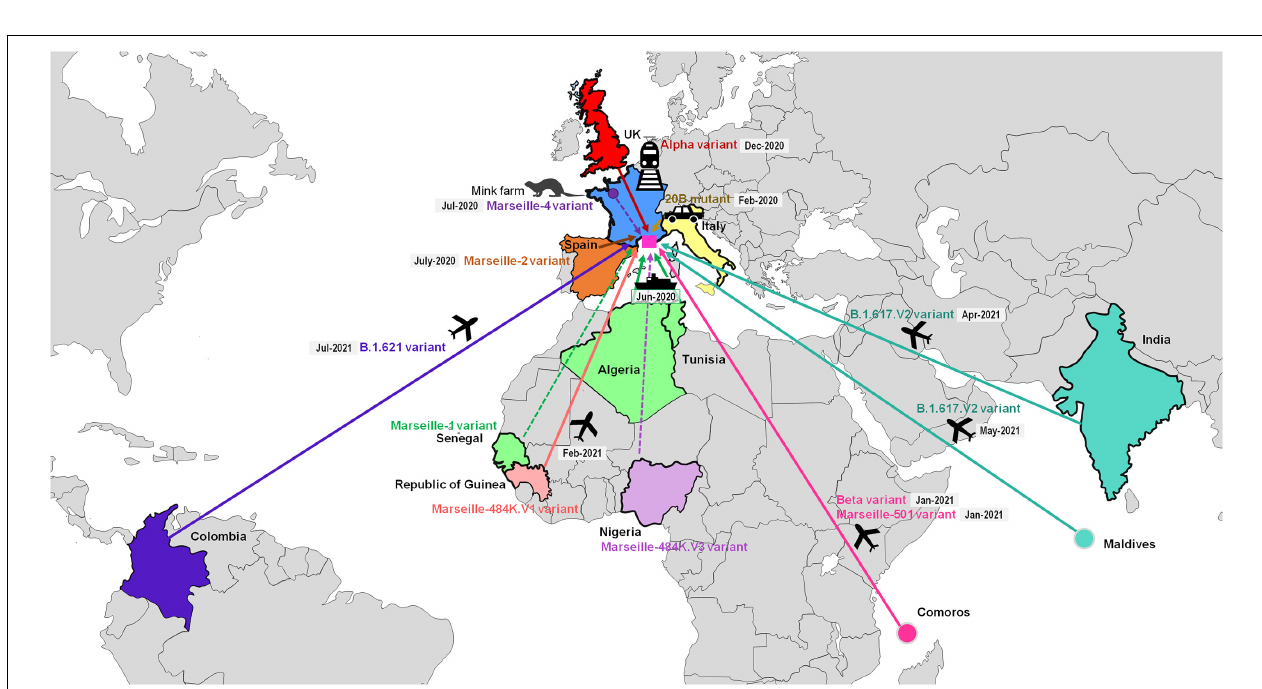
FIGURE 7 | Demonstrated or likely sources and origins of SARS-CoV-2 mutants or variants detected among patients SARS-CoV-2-diagnosed in our institute. See also IHU Méditerranée Infection (2021b; https://doi.org/10.35081/nz2g-f980).